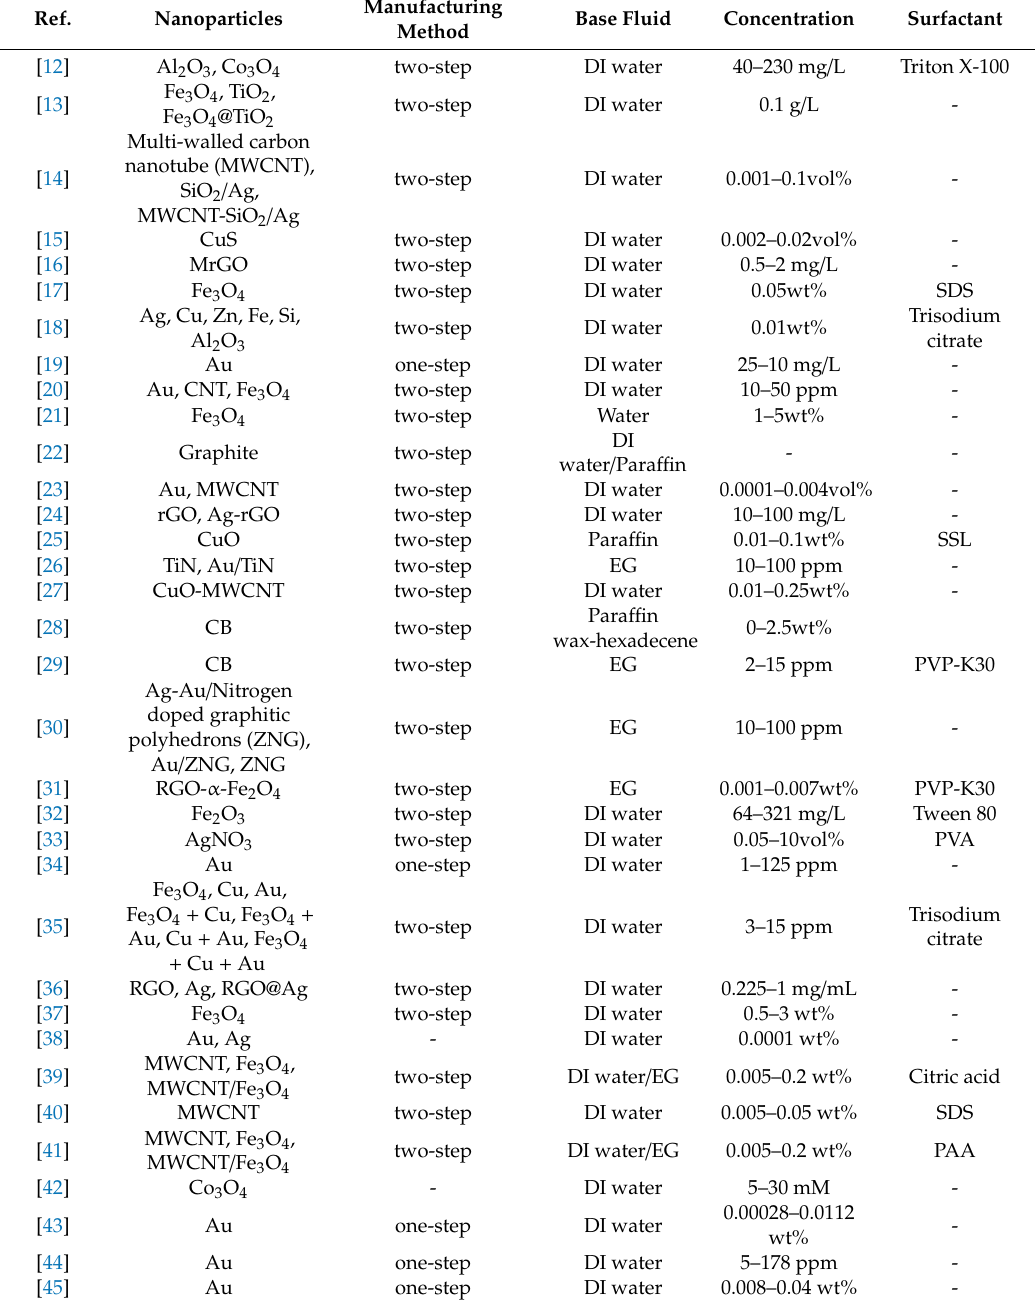
Table 1. Synthesis methods of